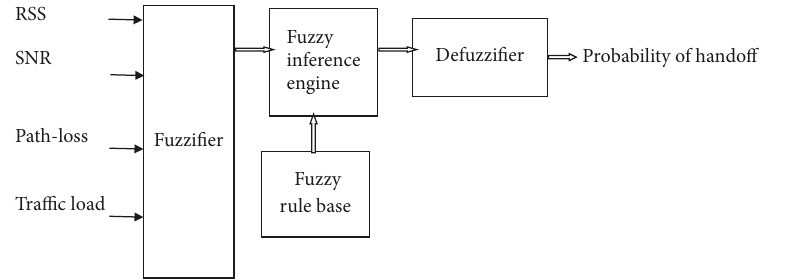
Figure 6: Structure of the proposed algorithm.